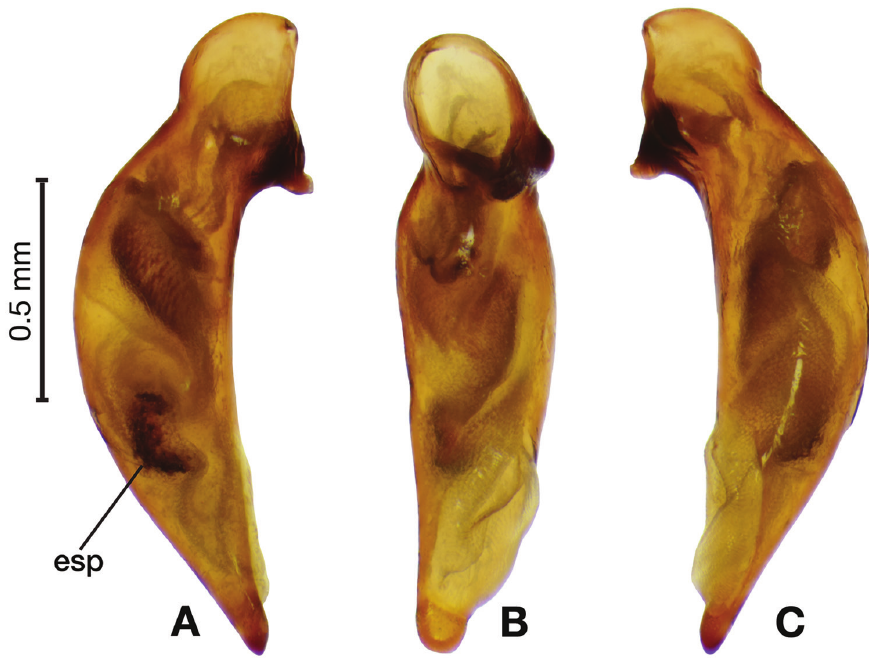
Figure 48. Digital images of male genitalia of C. ( Coptoderina ) marginata (Dupuis). A right lateral as- pect B ventral aspect C left lateral aspect. Legend: esp endophallic spine